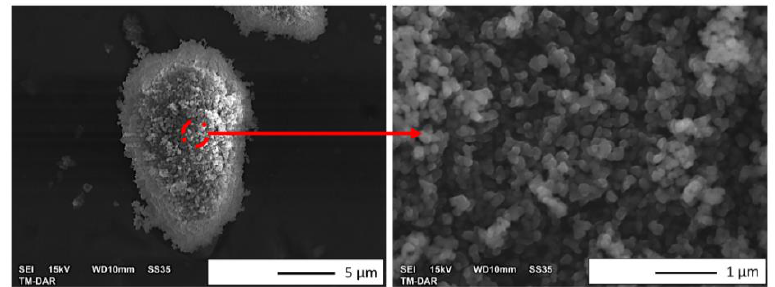
Figure 2. SEM images of the morphology of the Al 2 O 3 powder.